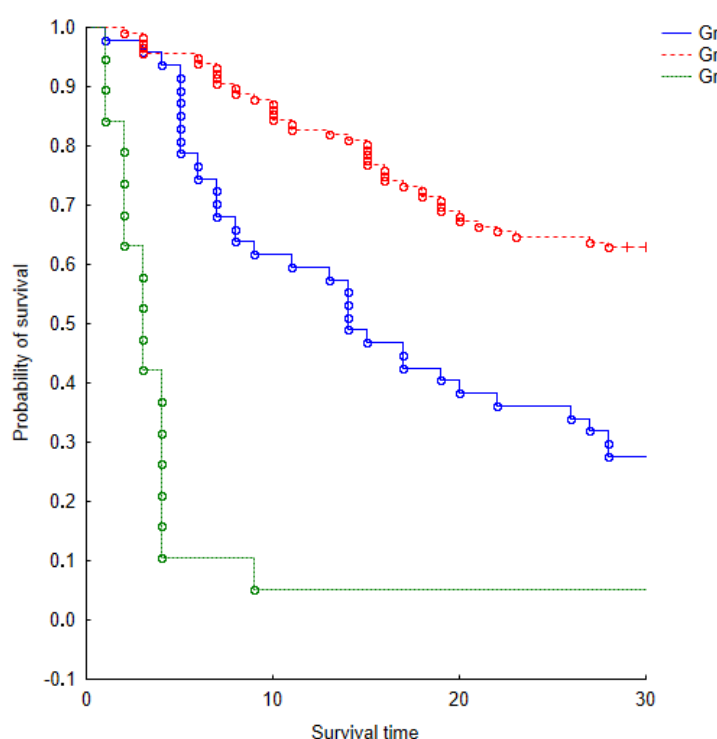
Figure 3. The Kaplan-Meier survival model for three groups of Experience Factors over a period of one